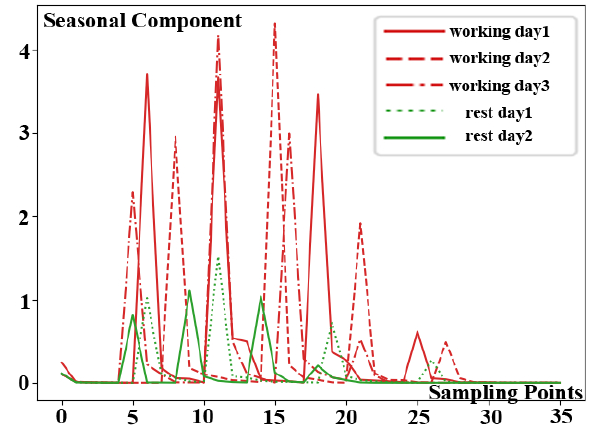
Figure 9. Clustering result of KPI time series data sub-sequences.